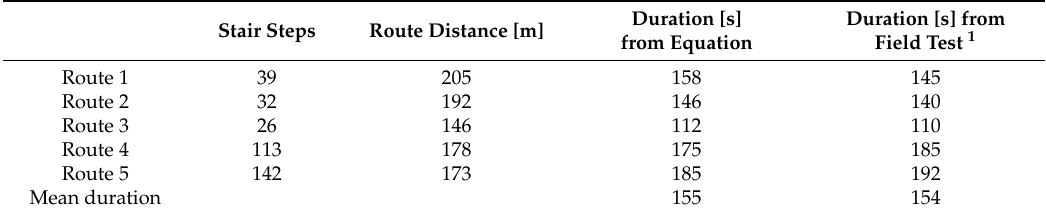
Table 2. Comparison of the estimated duration of physical activity from the equation and the collected